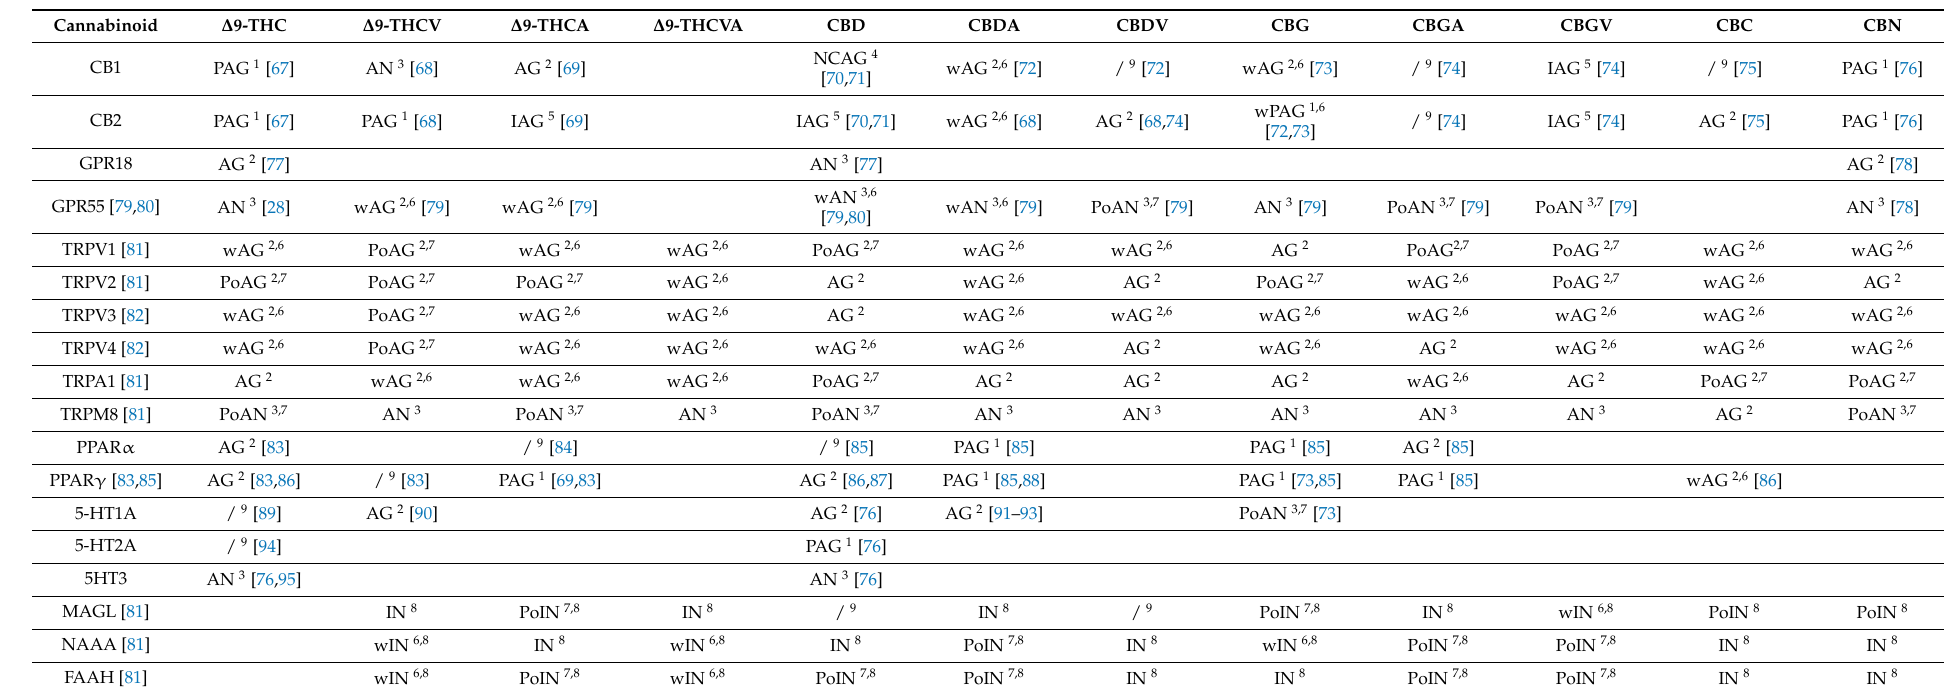
Table 2. Biodynamic effects of 12